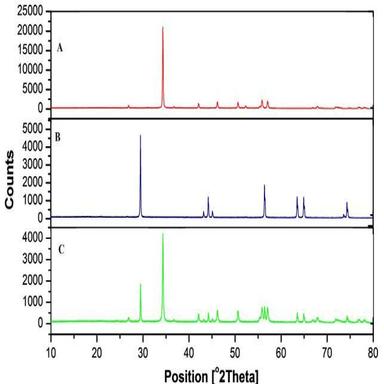
XRD pattern of (A) eggshell powder; (B) titanium dioxide; (C) TiO2-EB.